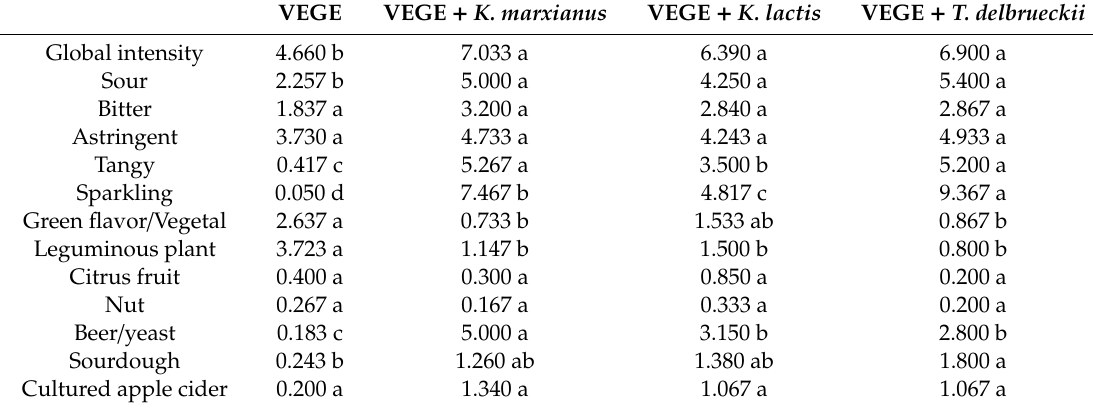
Table 2. Average intensity of sensory attributes determined for di ff erent fermented products using a scale ranging from 0 to 15.